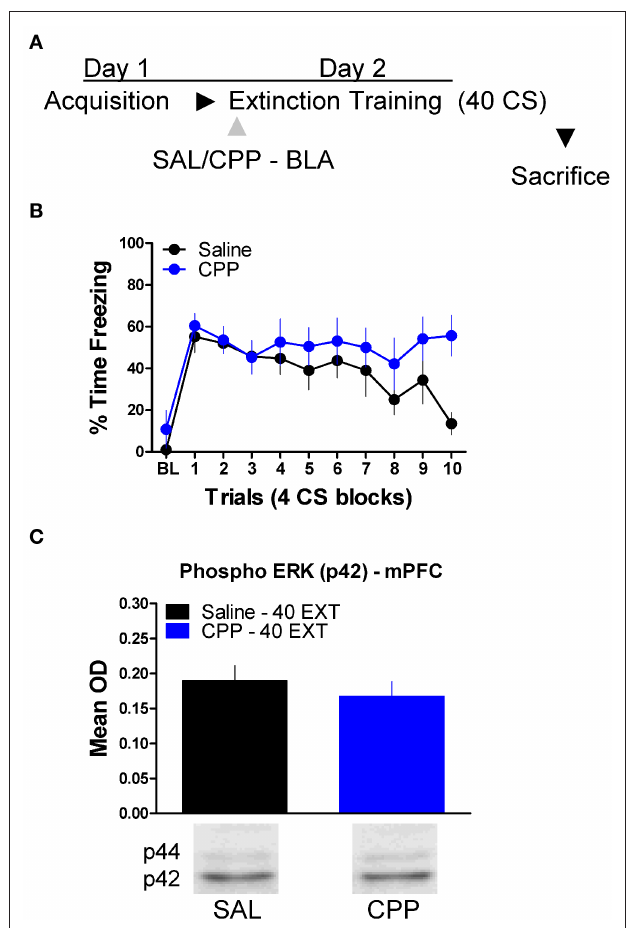
Figure 6 | N -methyl- d -aspartic acid receptor blockade in the amygdala has no effect on erK phosphorylation in the mPFC related to extinction training. (A) Schematic showing the behavioral procedures employed in this experiment. (B) Freezing to the CS during the 40 trials of extinction training. Expression of phosphorylated ERK in the amygdala mPFC (C) of rats infused with saline ( N = 8, black) or CPP ( N = 8, blue) into the amygdala and given 40 trials of extinction